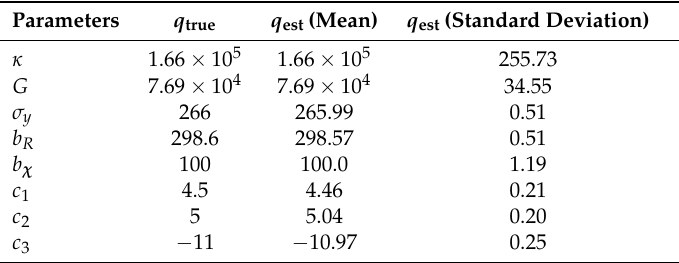
Table 3. The identified model